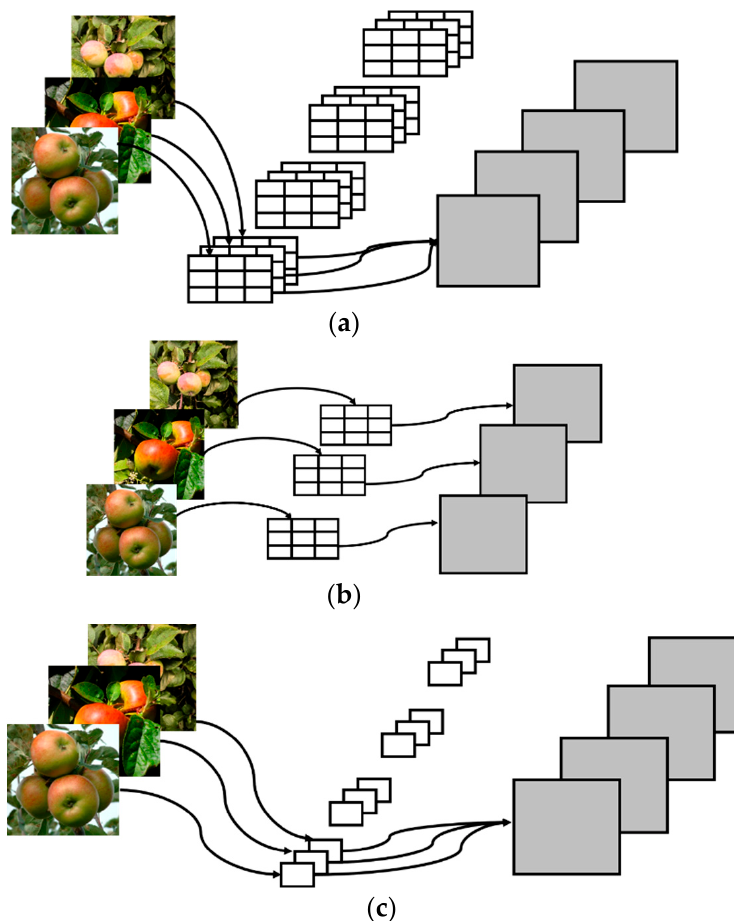
Figure 2. Standard convolution and depthwise separable convolution operation. ( a ) Standard con-